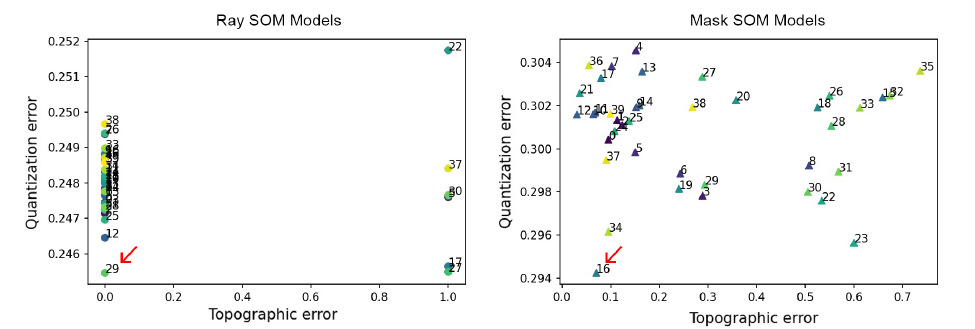
Figure 7. The scatter plots showing quantization error and topographic error of ray SOM models ( left ) and mask SOM models ( right ).